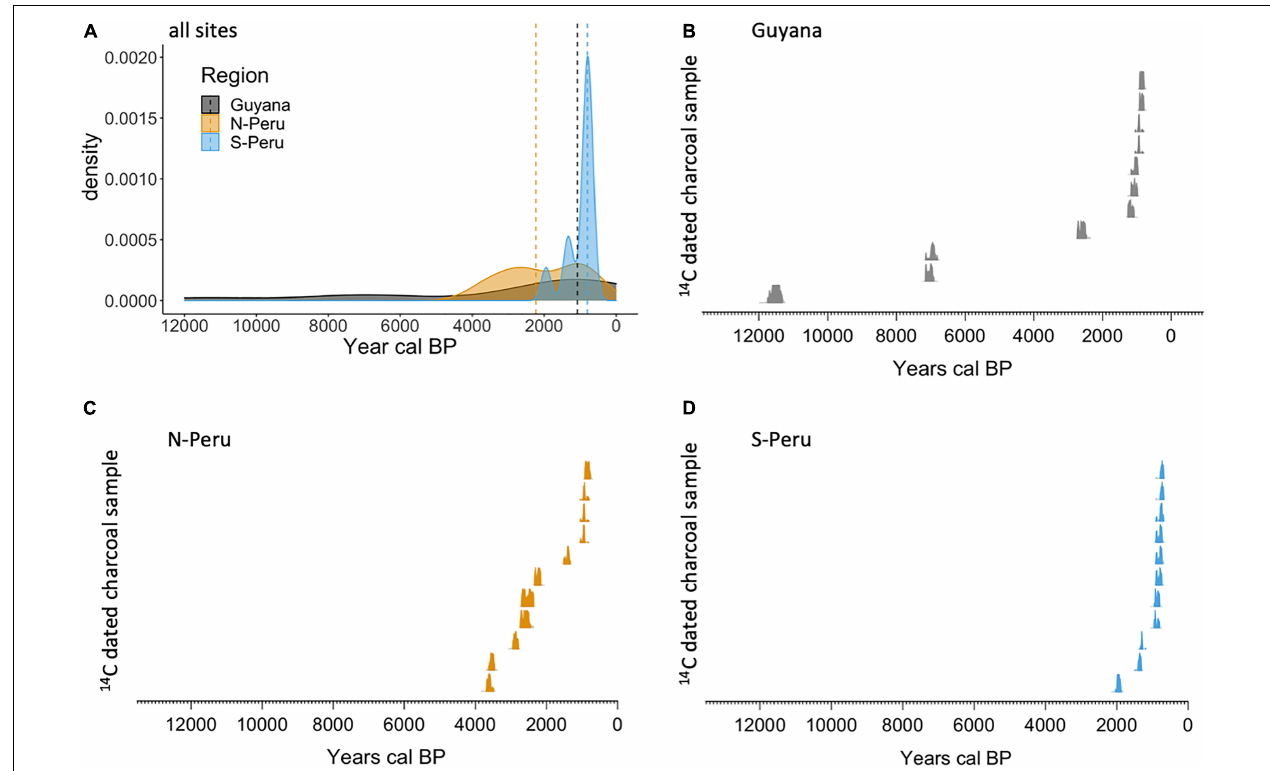
FIGURE 2 | (A) Density distribution for dates ( n = 33; cal years BP) by region for charcoal sampled in soil pits in Guyana, N-Peru and S-Peru. Dashed lines indicate median dates among all dates per region. Calibrated 14 C dates (cal years BP) for (B) Guyana, (C) northern Peru, and (D) southern Peru; each curve represents a charcoal